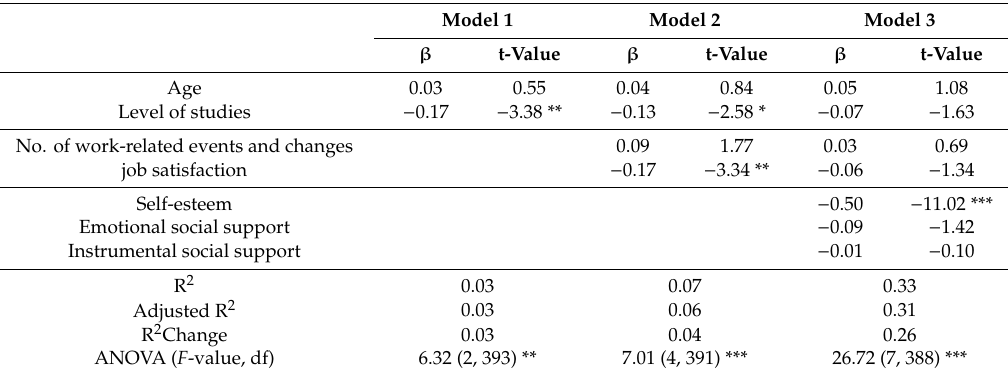
Table 3. Summary of the hierarchical multiple regression analysis with psychological distress as a dependent variable for the female